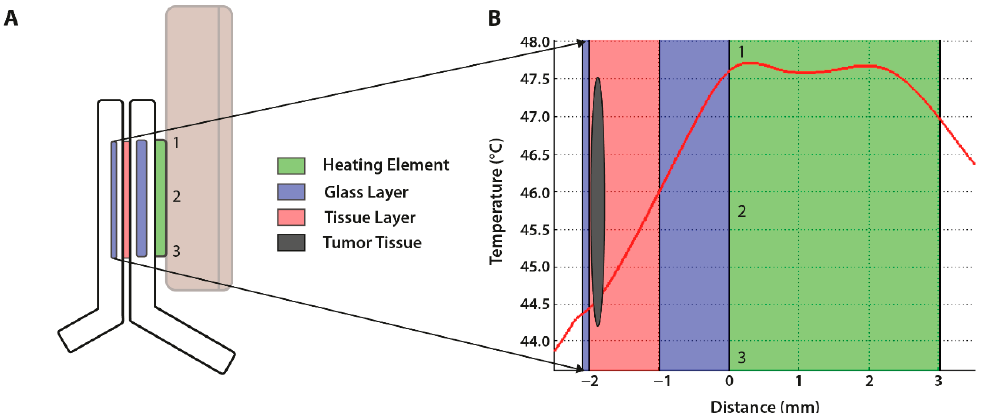
Figure 6. Schematic representation of the dorsal skinfold chamber (DSC) model. ( A ) The dorsal skinfold chamber was secured to the heating element. As shown, point 1 and 3 of the heating element (green) were in direct contact with the glass bottom layer (blue). Point 2 yielded no direct thermal conduction, as the hollow bore of the element was located at that site. ( B ) The SEMCAD X simulated temperature profile of the DSC model. The temperature within the heating element (green) approximated the set temperature. Upon conduction into the bottom glass layer (blue), the temperature decreased and continued to decline as heat transferred into the tissue layer (red), upper glass layer (blue), and air (white). The SEMCAD X simulation indicated that the device temperature had to be set at ±47.5 °C in order to reach a tissue temperature of ±44.5 °C (black oval ) .